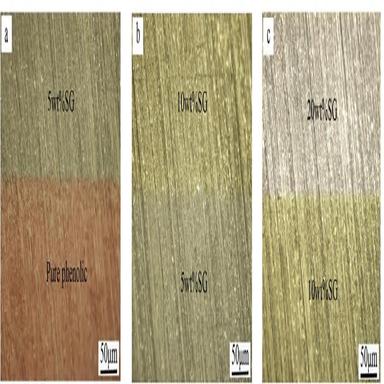
ptical micrographs of bulk FGPMs, a) Pure phenolic resin to 5 wt% of synthetic graphite (SG) as reinforcement, b) 5 wt%-10 wt% SG, c) 10 wt%-20 wt%SG from . Source